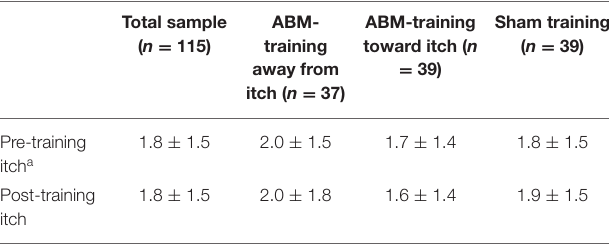
Table 5 | Mean ± standard deviation of mechanically evoked itch measured on a numeric rating scale from 0 (no itch) to 10 (worst itch imaginable) displayed for the total sample and per attention bias modification (ABM) training condition.